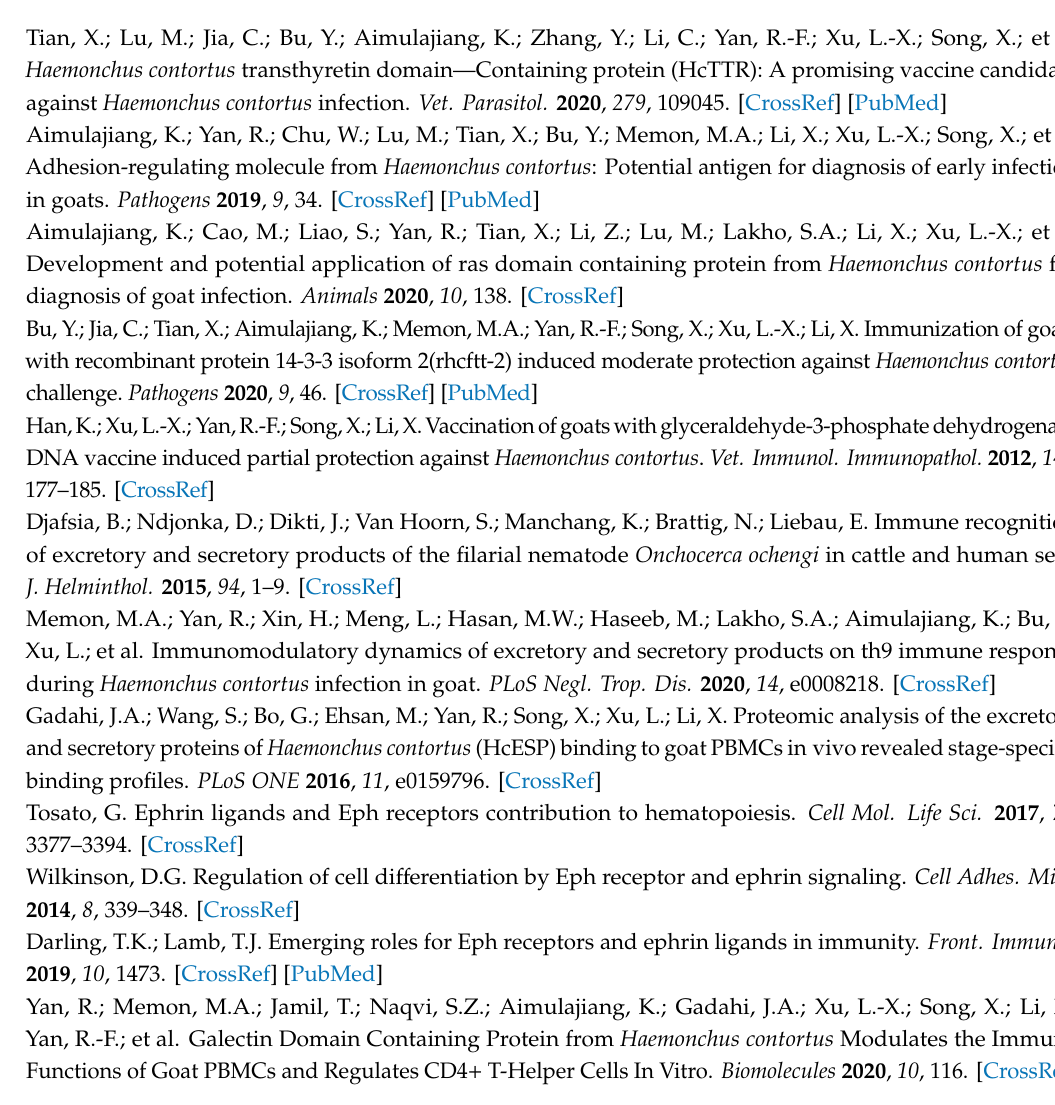
Table S1: Primer sequences for FQ-PCR, Instruction S1: Instructions of T4 DNA ligation